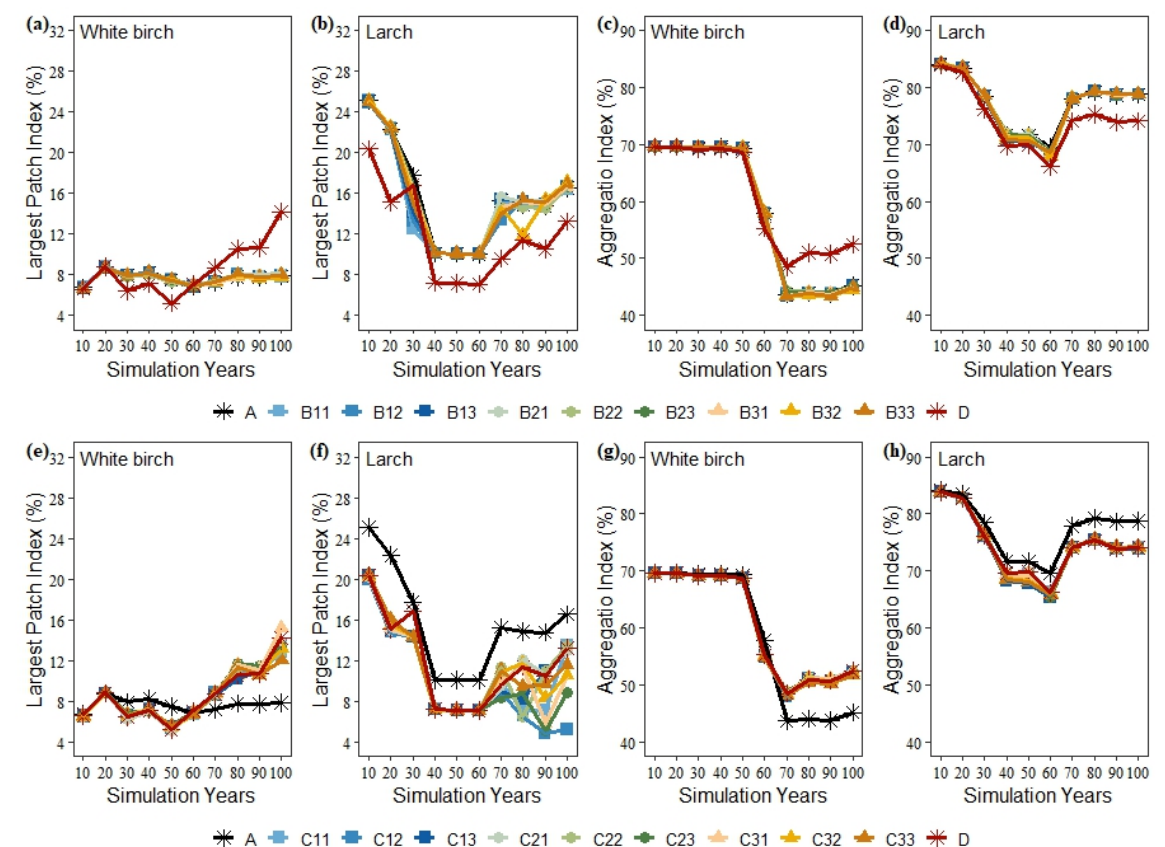
Figure 6. Largest patch index (LPI) and aggregation index (AI) for all scenarios. Scenario A and scenario D are the baseline scenarios for comparison, and they do not treat for fuels. ( a , b ) are the LPIs for white birch and larch, respectively, under the nine fuel treatment plans in scenario B. ( c , d ) are the AI of white birch and larch, respectively, under the nine fuel treatment plans in scenario B. and ( e , f ) are LPI for white birch and larch, respectively, under the nine fuel treatment plans in scenario C. ( g , h ) are the AI of white birch and larch, respectively, under the nine fuel treatment plans in scenario C.